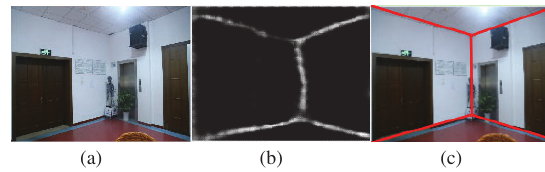
Figure 11. Indoor spatial layout estimation results. (a) shows the input images of SLENet. (b) shows the rough spatial layout estimation results with our Network. (c) shows the detail spatial layout extraction